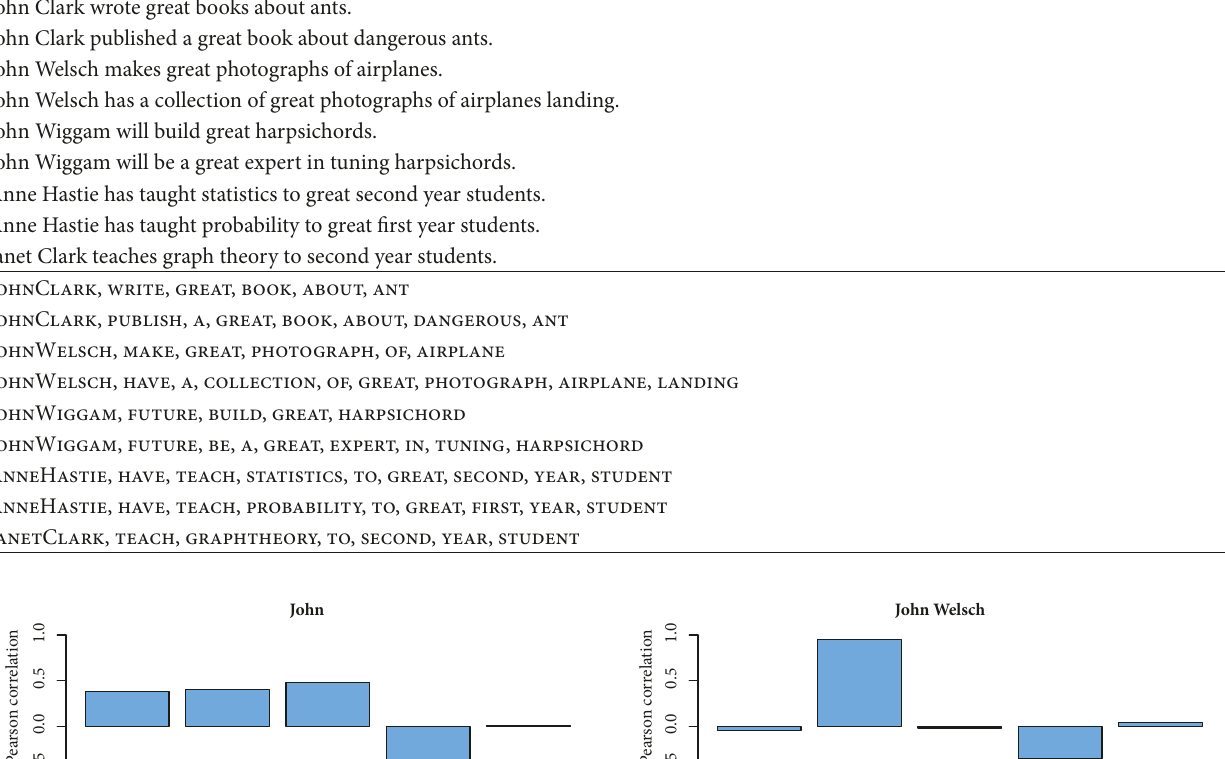
Table 8: Example sentences for the reading of proper names. To keep the example simple, inflectional lexomes are not taken into account. John Clark wrote great books about ants.